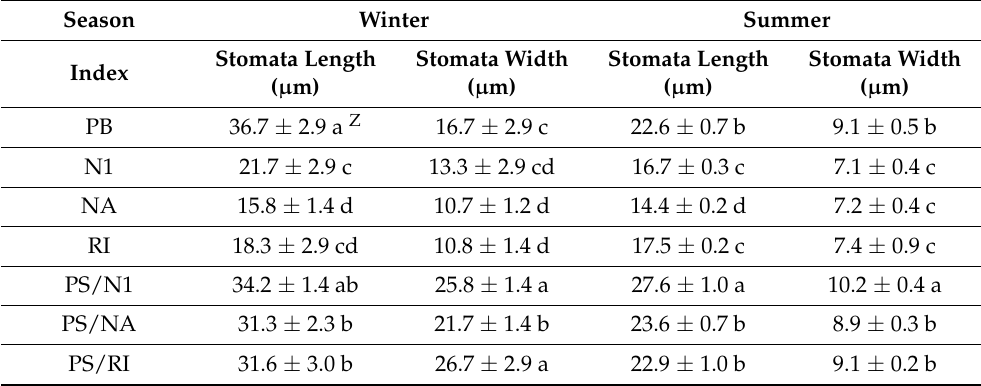
Table 3. The stomata size of one scion, three rootstocks, and three grafted plants measured by scanning electron microscopy in winter and summer.